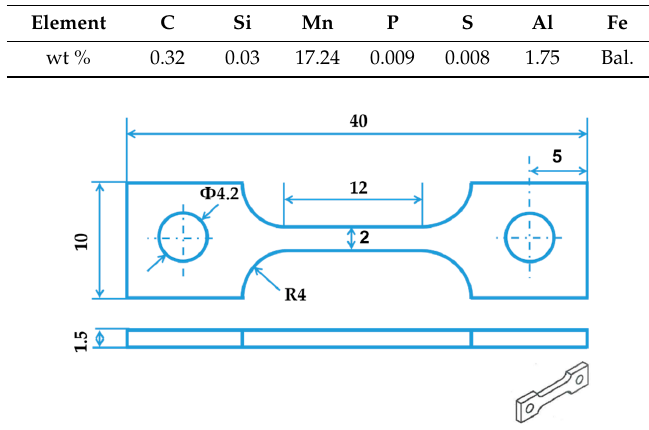
Table 1. Chemical composition of the Fe-17Mn-1.5Al-0.3C steel.